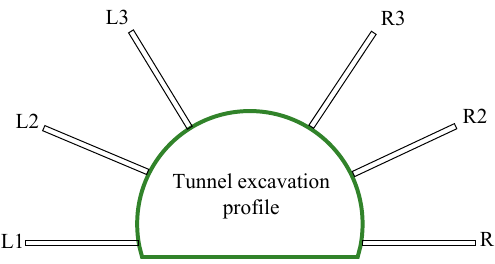
Figure 7. Schematic diagram of test hole layout.